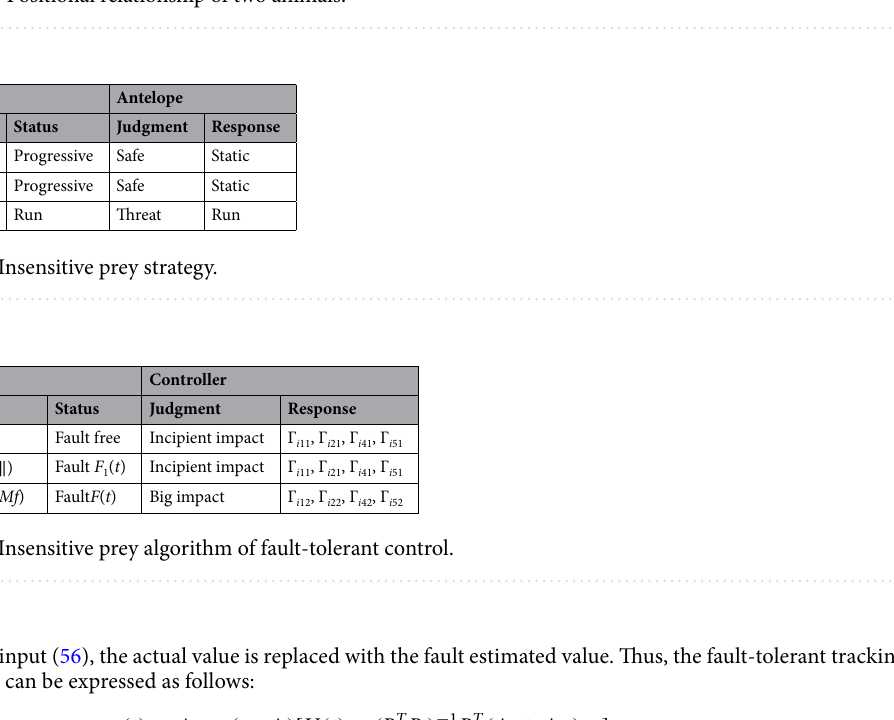
Figure 3. Positional relationship of two animals.